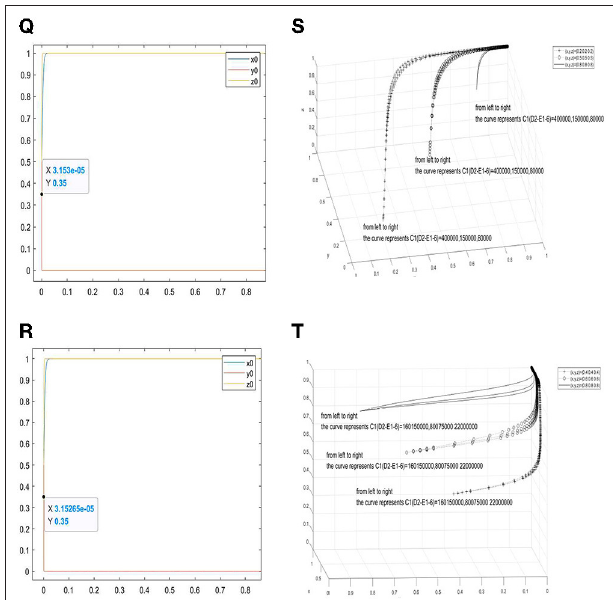
FIGURE 4 | Evolutionary simulation results of the parameter C 1( D 2 − E 1 − 6). (A–R) the value range of the abscissa when the ordinate is 0.98 under different factors. (S,T) the three-dimensional comparison diagrams under the three-way selection